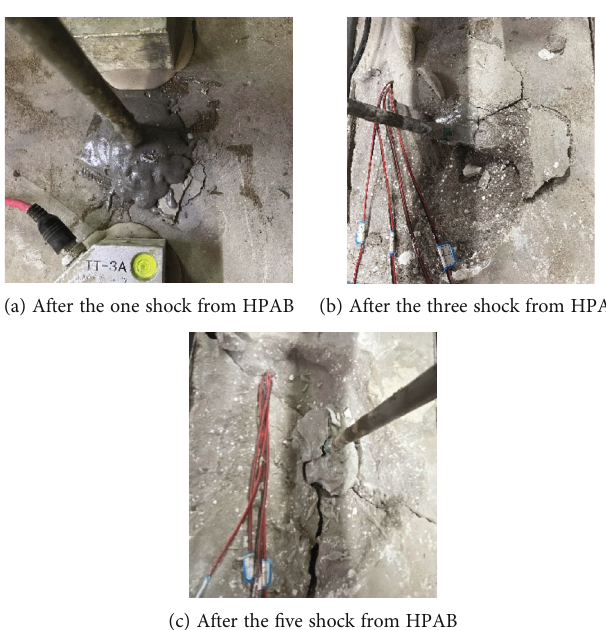
Figure 8: Surface rack evolution of specimen under multiple HPAB.